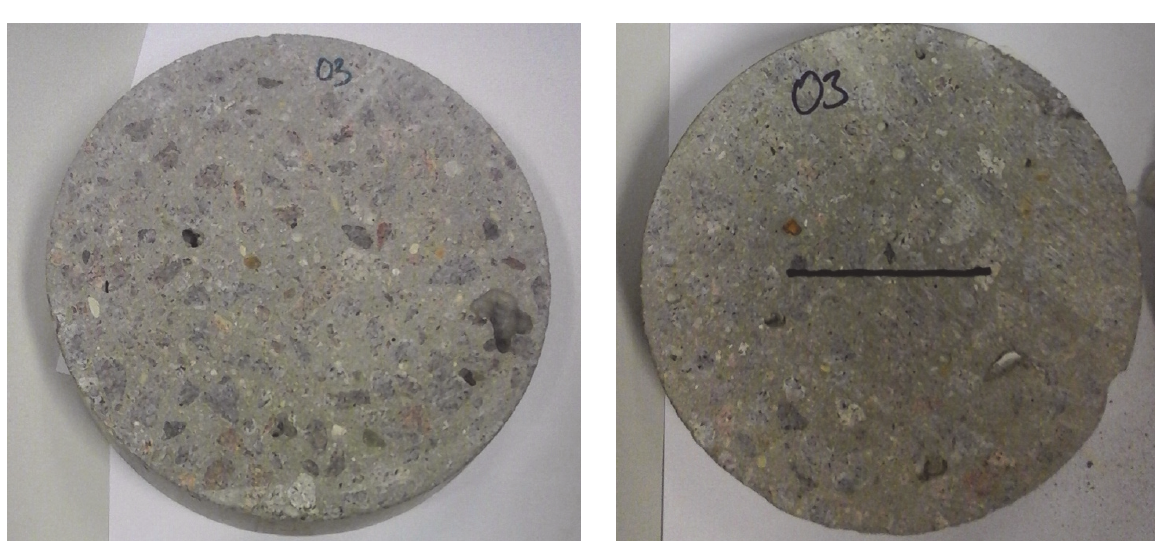
Figure 4: Example of specimens used for Brazilian disc test without and with notch Specimen nmr.